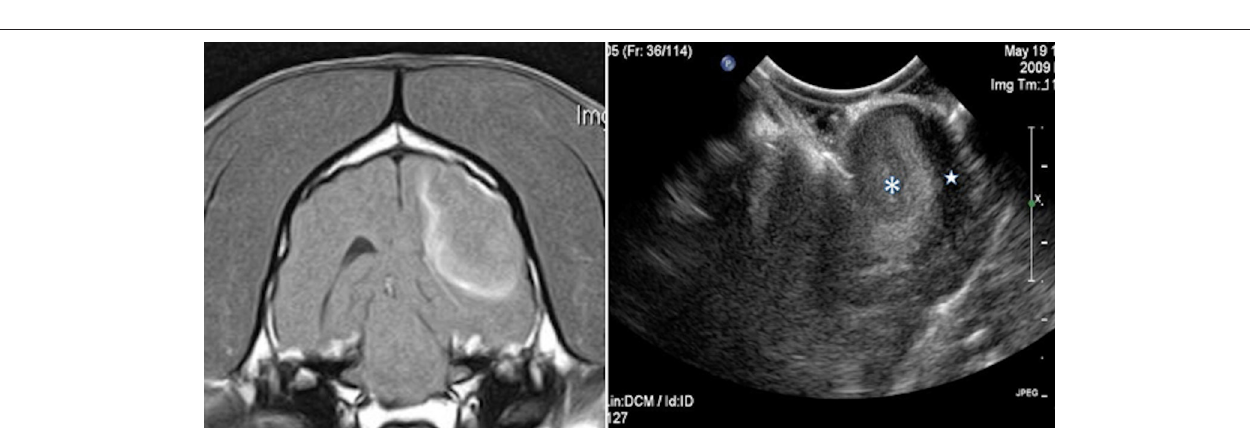
FIGURE 5 | Case 1. Left, a transverse T1 + Contrast image of a meningioma. Right, a sagittal intraoperative ultrasound showing the mass ( * ) and adjacent lateral ventricle ( *